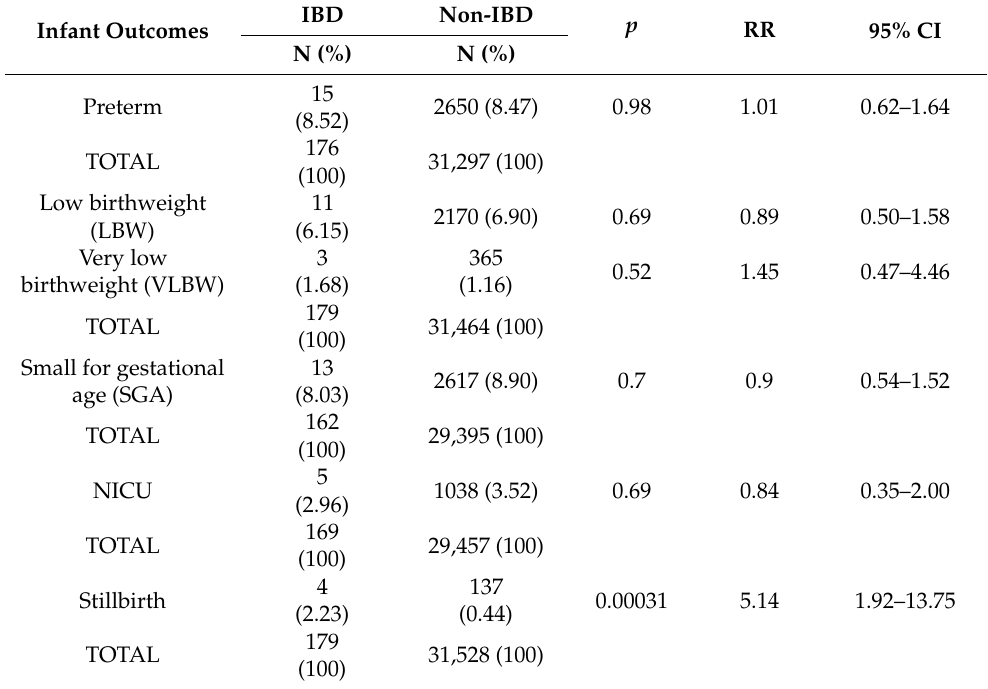
Table 5. Neonatal